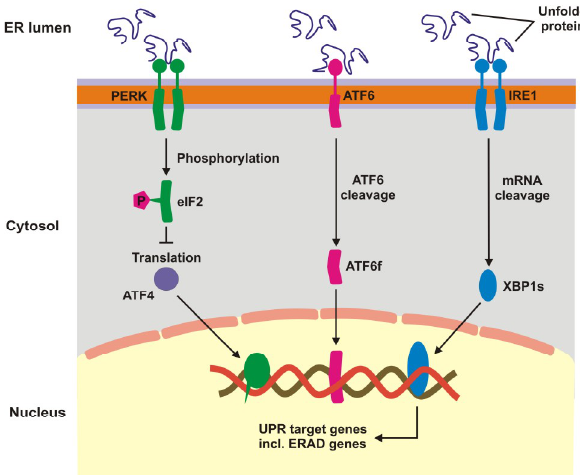
Figure 6. Unfolded protein response. When unfolded, misfolded and damaged proteins accumulate in endoplasmic reticulum (ER), they can induce unfolded protein response (UPR), a signaling cascade with the involvement of protein kinase-like endoplasmic reticulum kinase (PERK), inositol requiring enzyme 1 (IRE1), and activating transcription factor 6 (ATF6). This cascade leads to a stop in translation of faulty proteins, degradation of misfolded proteins and increased synthesis of chaperons involved in protein folding. If these mechanisms fall, UPR switch to pro-apoptotic response. XBP1s—X-box binding protein 1 specificity protein, eIF2—translation initiation factor 2, ERAD—ER-associated degradation, ATF6f—the transcriptional activator domain of ATF6, P—phosphate